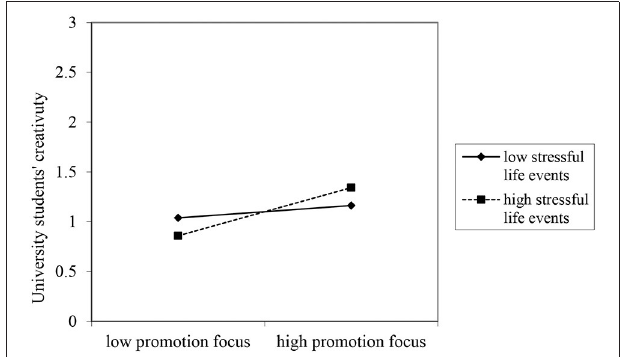
FIGURE 4 | Moderated mediating effects of stressful life